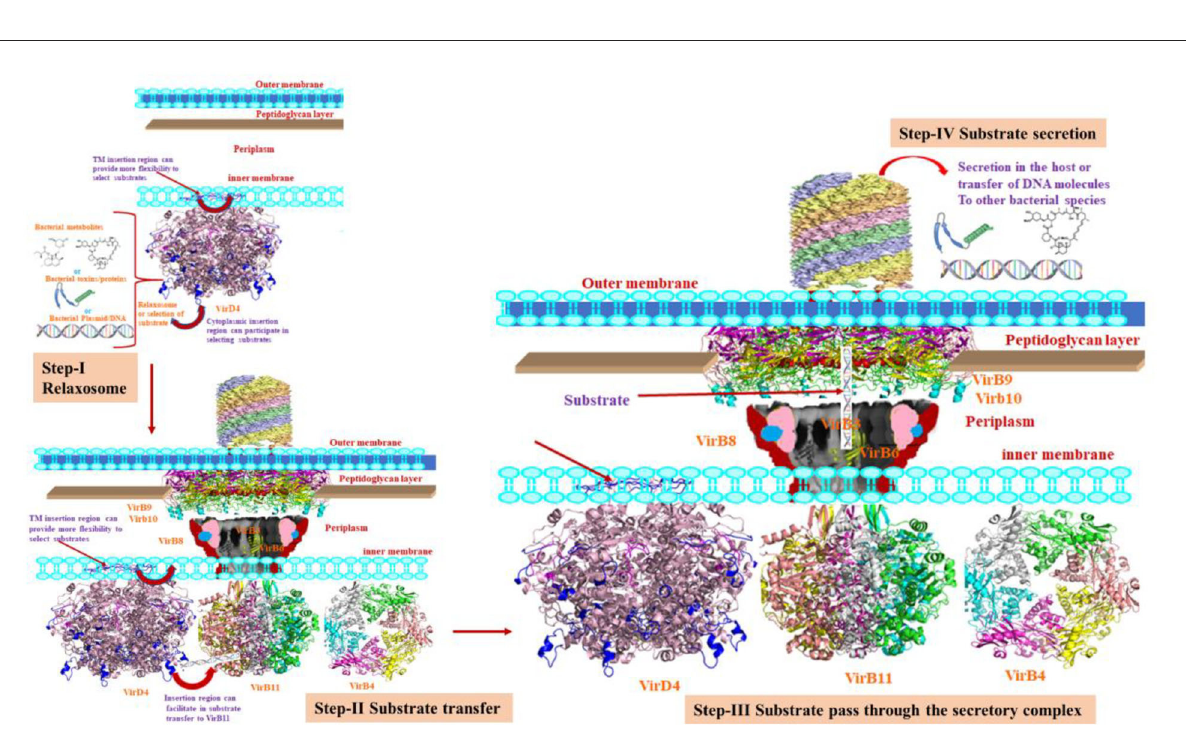
FIGURE5 The various steps of the secretion process. Step-I shows the relaxosome where VirD4 recruits the substrate. During this process, the insertion regions may allow flexible movements. Step II shows the transfer of substrate to VirB11. This cartoon also depicts VirD4 possibly interacting with VirB11. Step III shows the translocation of the substrate through the secretory machinery. Step-IV shows the secretory products to the host cells to transfer to bacterial